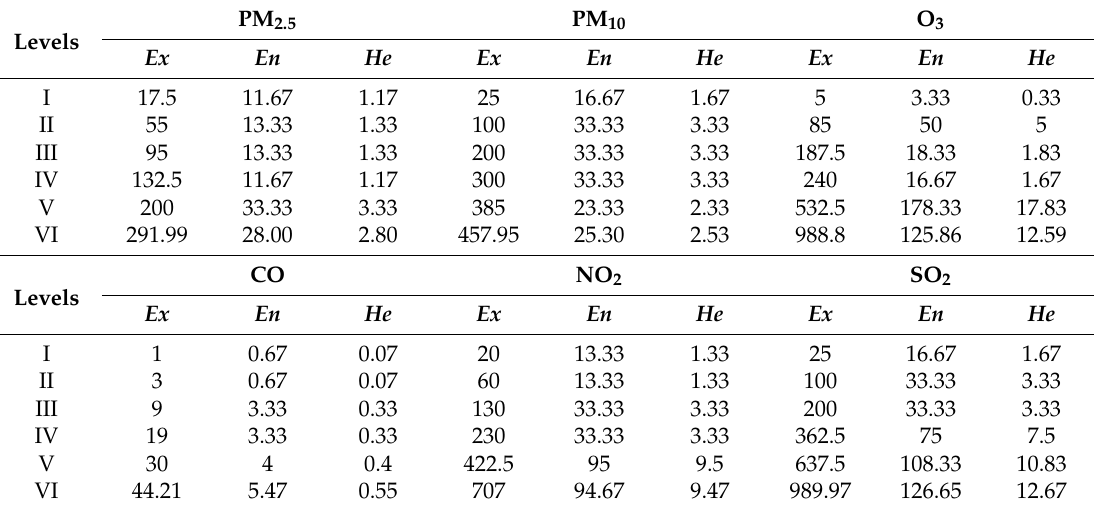
Table 10. The parameters of the cloud model for all